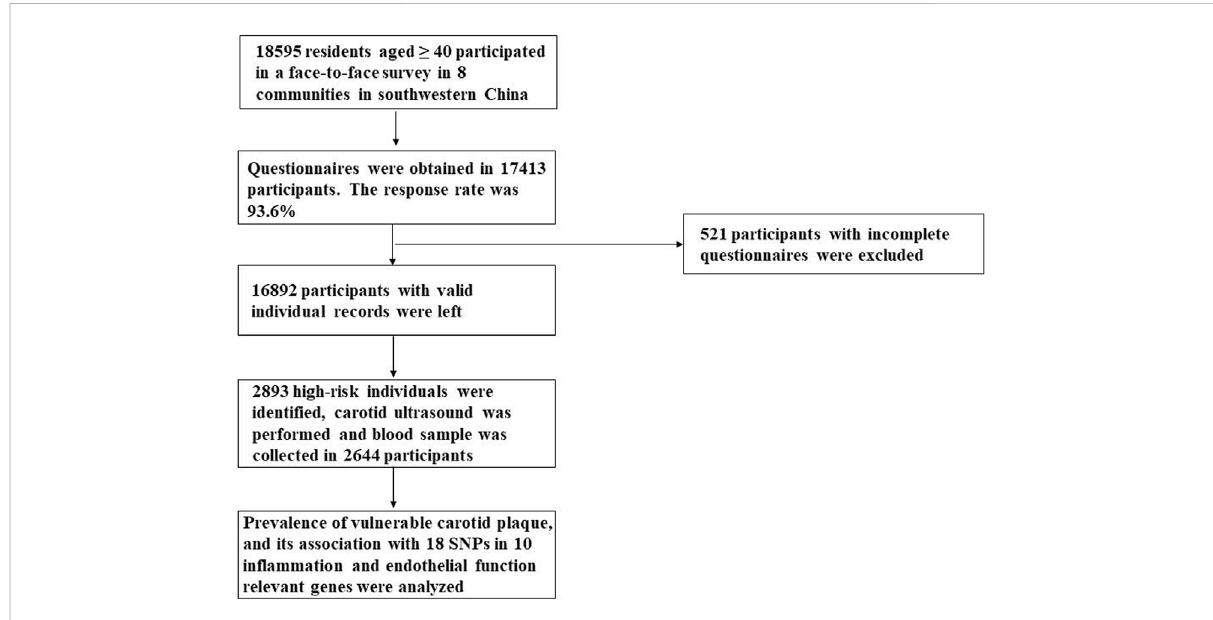
FIGURE 1 Flow diagram of the data preparing and cleaning process in this